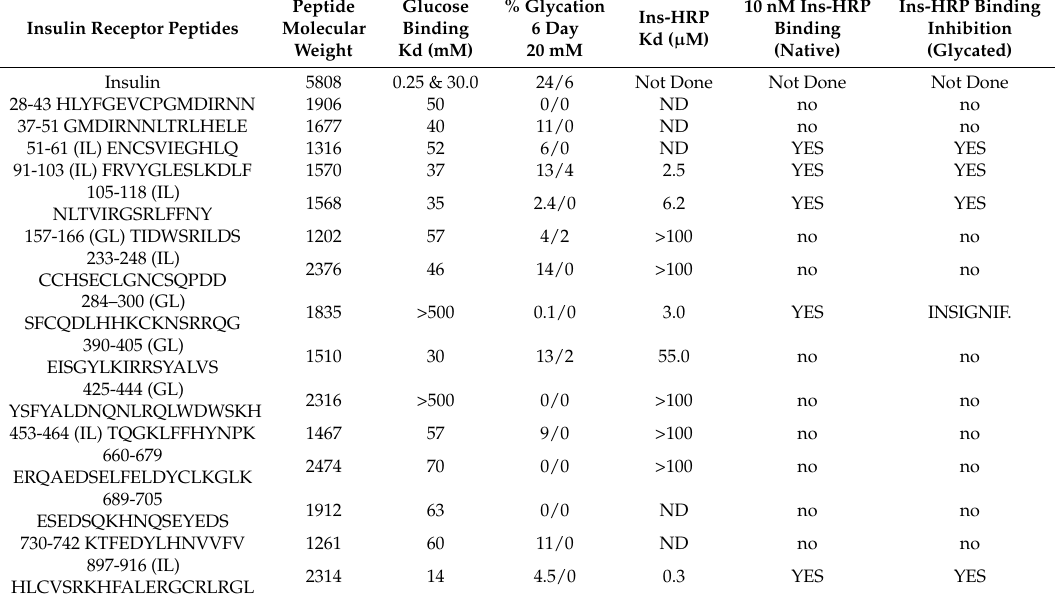
Table 1. Table summarizing experiments to identify motifs determining insulin-receptor (IR) peptide glycation and whether glycation of IR peptides results in inhibition of insulin binding to these peptides. Specifically, this table provides binding constants glucose binding non-covalently to various insulin receptor (IR) peptides; glycation of the same IR peptides at 20 mM glucose for six days; the binding constants ( µ M) of insulin-HRP (Ins-HRP) to IR peptides from (40, 41) binding of Ins-HRP at 10 nM to the IR peptides in the absence of glycation; and whether there is a change in Ins-HRP binding at 10 nM to each IR peptide after exposure to glycating conditions (six days at 20 mM glucose). Some peptides glycated at more than one position, so the column showing “% Glycation” shows the percent of peptide glycated at the primary site followed by the percent glycated at the secondary site. The numbers of the IR peptides at the left refer to the UniProt numbering system for the human IR (P06213). The abbreviations in parentheses following the peptide number refer to whether the peptide mimics insulin (insulin-like or IL) or glucagon (glucagon-like or GL) (see [38,40,41]). Known enzymatic glycosylation sites (N-acetylglucosamine) are indicated by the bolded N (asparagine) with a grey background (see UniProt P06213 at www.expasy.org). Lysines (K), which are often targets of